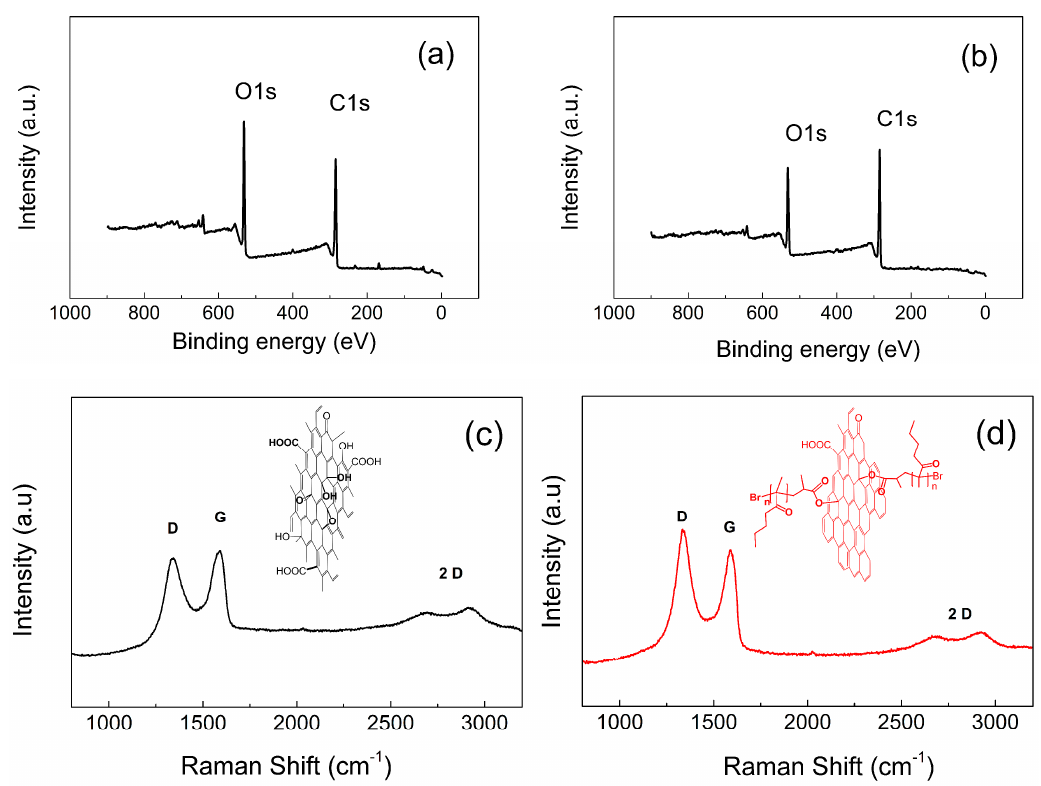
Nanomaterials 2019 , 9 , x FOR PEER REVIEW Figure 5. XPS spectra for neat GO ( a ) and GO-PBMA ( b ) and Raman spectra ( c , d ) for the same. Table 1. The chemical composition on the surface of neat GO, GO-I and GO-PBMA. All values are in atomic %.